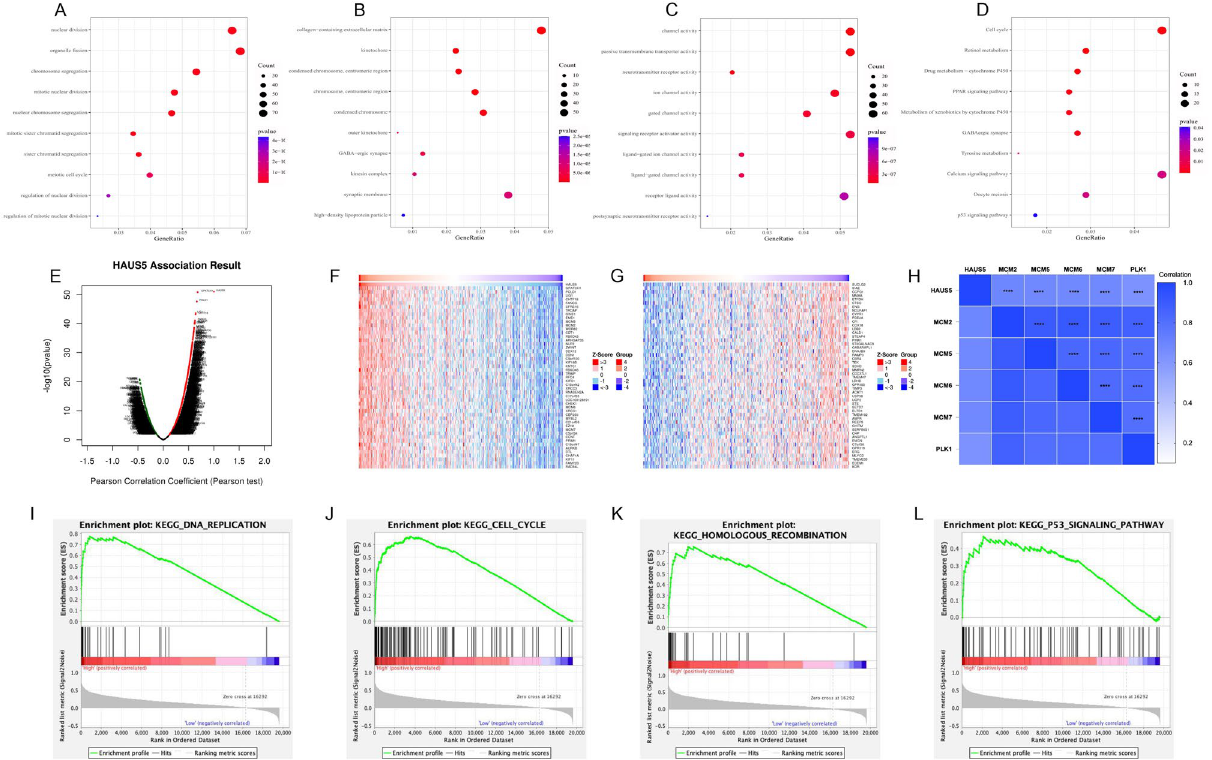
Figure 7. Functional enrichment analysis and co-expressed genes of HAUS5. GO function enrichment analysis based on three aspects, including ( A ) BPs, ( B ) CCs, and ( C ) MFs. ( D ) KEGG pathway enrichment analysis (Sourced from www. kegg. jp/ kegg/ kegg1. html). HAUS5 co-expressed genes in LIHC analyzed by the LinkedOmics database. ( E ) Volcano map of genes highly correlated with HAUS5 according to Pearson’s test in the LIHC cohort. ( F , G ) Heatmaps show the top 50 positively correlated genes and negatively correlated genes of HAUS5 in LIHC datasets. ( H ) Heatmap of the relationship between HAUS5 and cell cycle-related genes. GSEA showed pathways enriched in ( I ) DNA replication, ( J ) the cell cycle, ( K ) homologous recombination and the ( L ) P53 signaling pathway. *P < 0.05, **P < 0.01, ***P < 0.001, ****P <